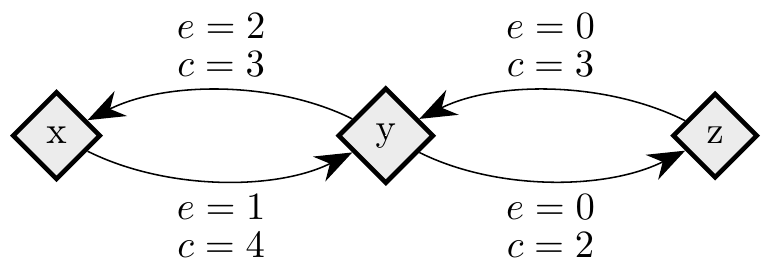
Figure 2. Coalitional Stochastic Stability. There are three states, x , y and z , all assumed to be rest points of an individualistic best response dynamic. Arrows between states indicate, for the most probable transition path from one state to another, e , the number of random errors on this transition path, and c , the size of the largest coalition that makes a coalitional response on this